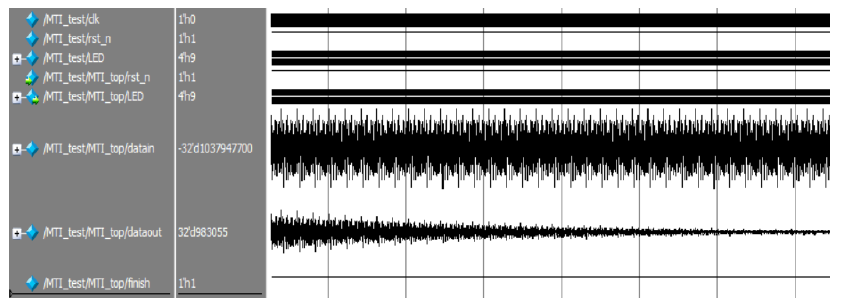
Figure 16. Moving target detection after filtering.